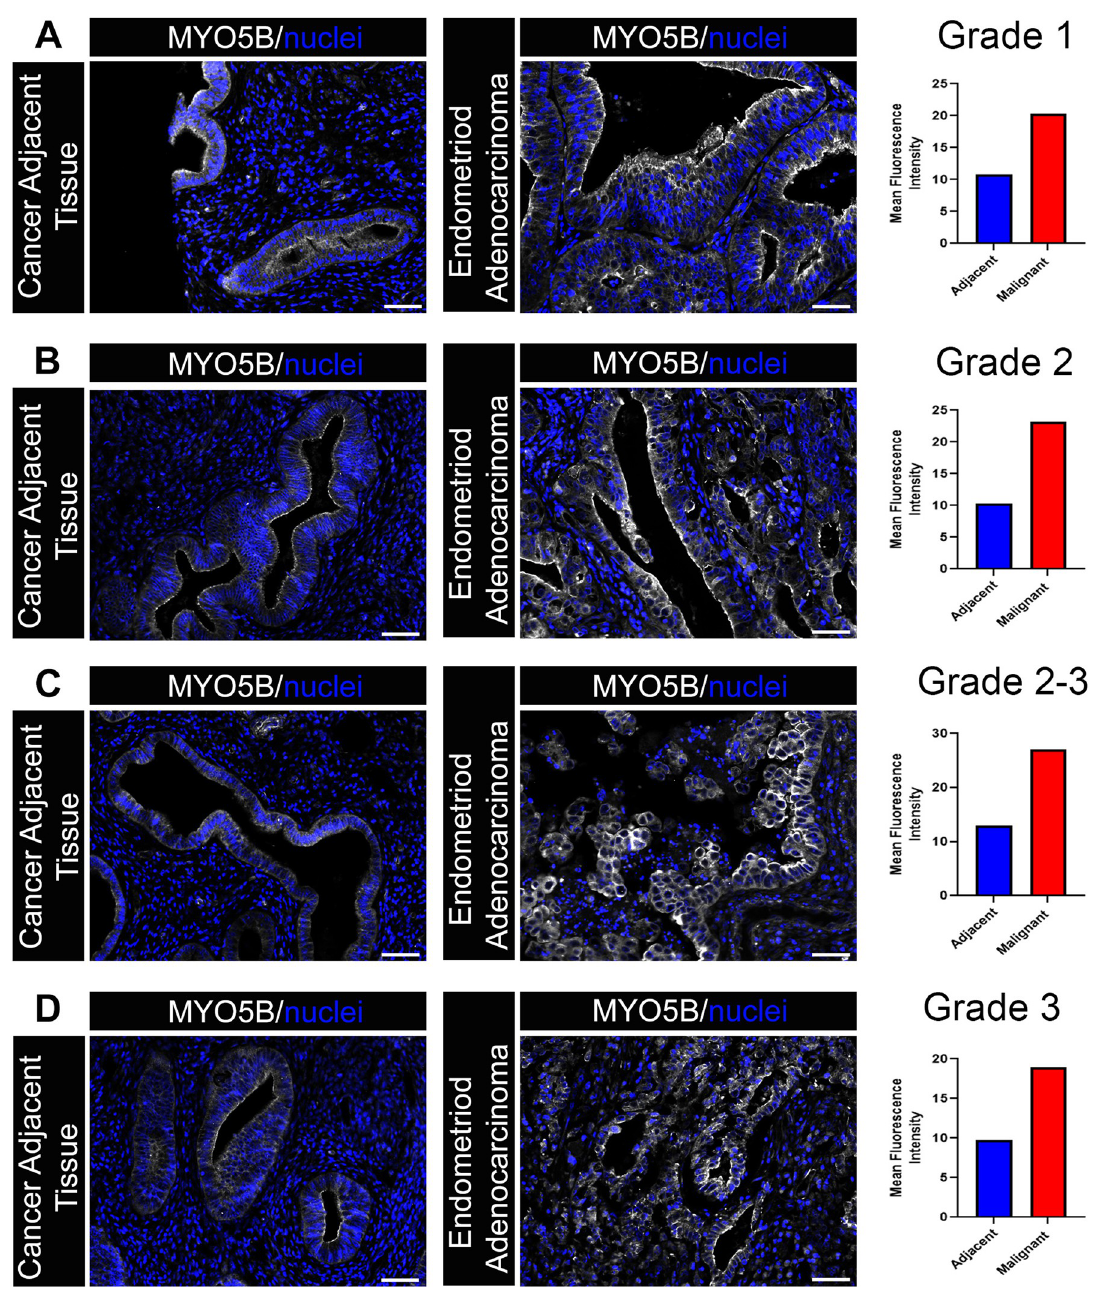
Fig 5. MYO5B protein is elevated in endometroid tumors, a subset of UCEC tumors. Immunostaining of endometroid tumors and adjacent uninvolved regions of endometrium. MYO5B is denoted in grey and nuclei in blue for A. Grade 1 tumors, B. Grade 2 tumors, C. Mixed Grade 2/3 tumors, and D . Grade 3